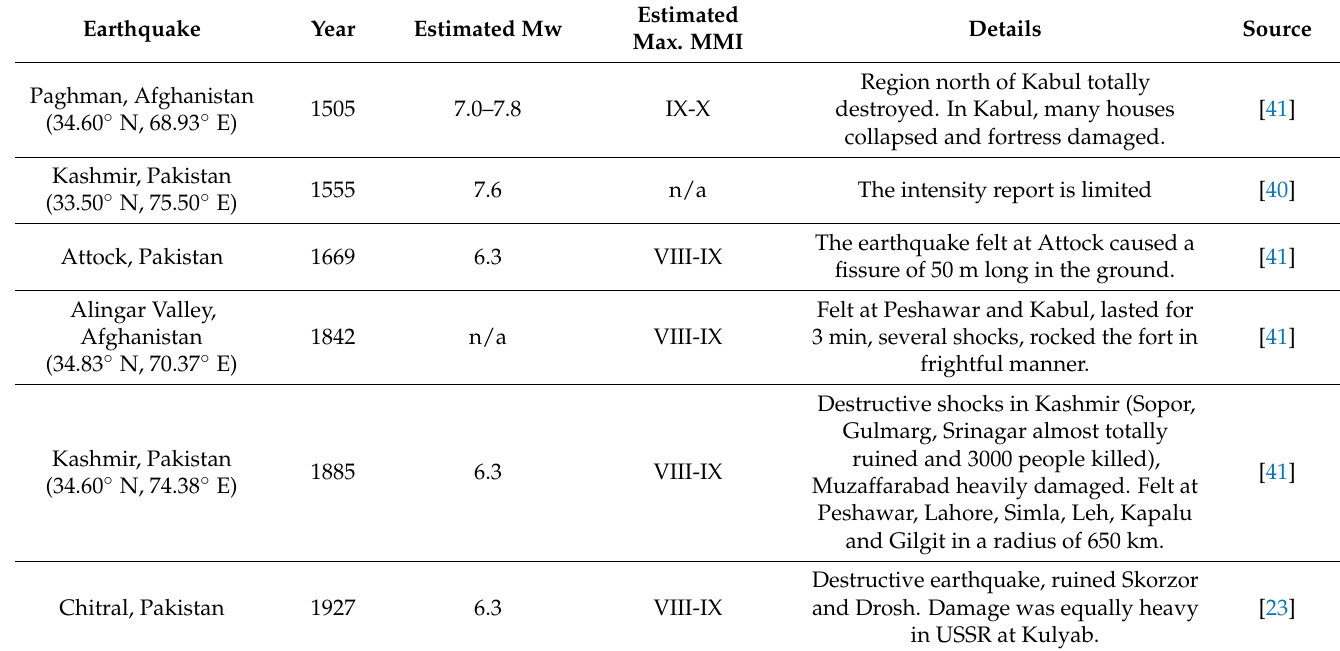
Table A1. Major historical earthquakes in the study